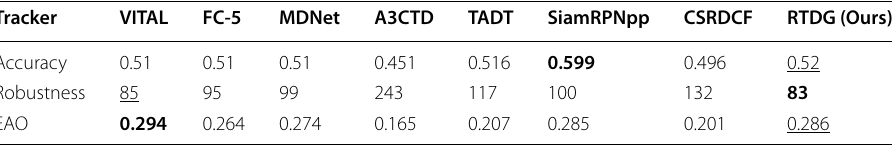
Table 3 Comparison of the state‑of‑the‑art trackers on VOT2019 dataset Tracker VITAL The bolded values are the best ones and the underlined values are in the second order